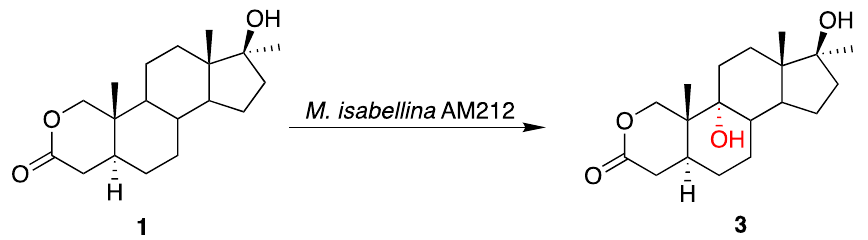
Figure 2. Transformation of oxandrolone ( 1 ) in the culture of Mortierella isabellina AM212.